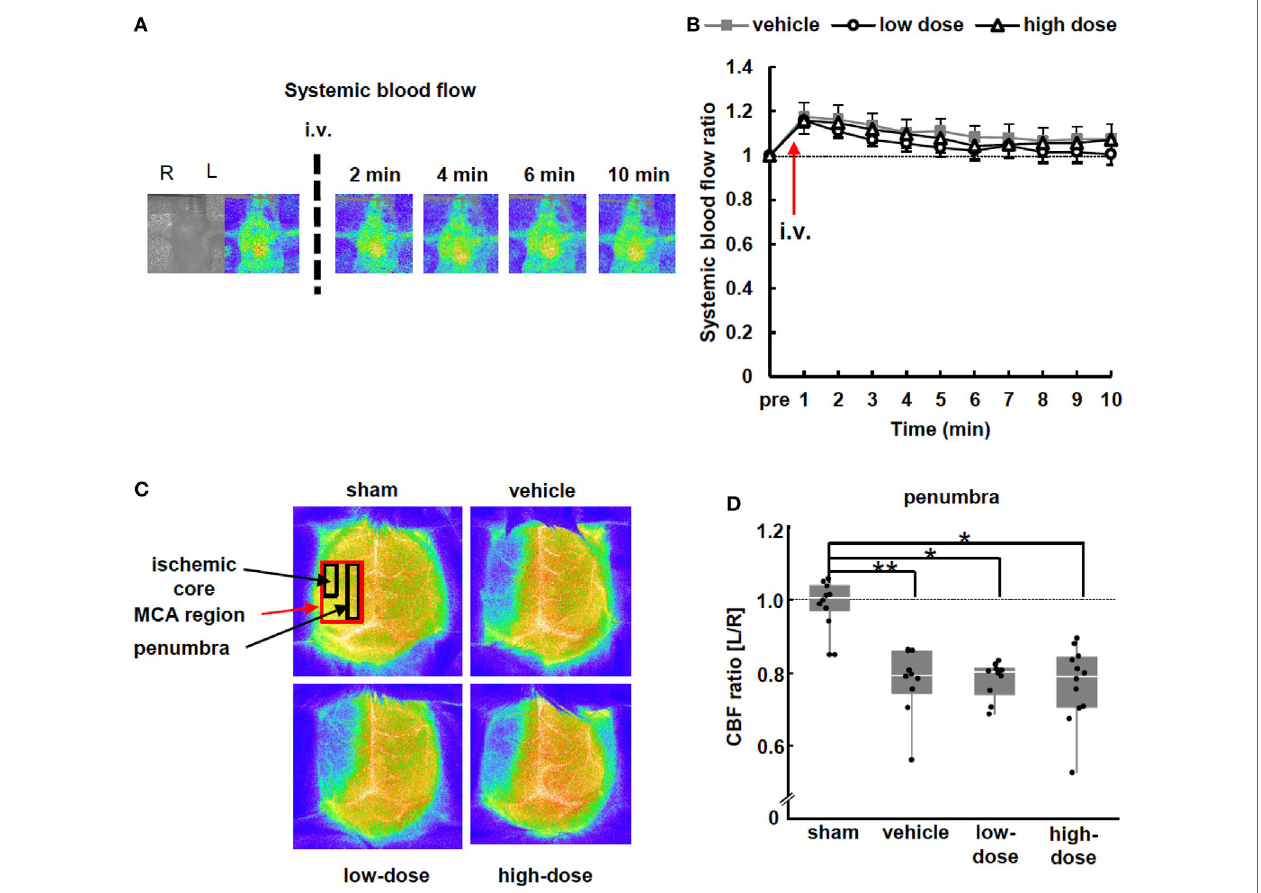
FigUre 2 | Blood flow measurements. (a) Representative images of systemic blood flow before and immediately after umbilical cord-derived MSC administration. (b) Systemic blood flow presented as a ratio to the pre-injection level. There were no significant differences between the vehicle and UC-MSC groups in systemic blood flow (vehicle n = 7, low-dose n = 8, and high-dose n = 8). (c) Representative images of cerebral blood flow (CBF) 24 h after administration. CBF decreased in the middle cerebral artery (MCA) region on the ipsilateral side of middle cerebral artery occlusion. (D) The CBF ratio of ipsilateral/contralateral hemispheres in the penumbra significantly decreased after MCAO. UC-MSC injection did not increase the CBF ratio. ** p < 0.01 and * p < 0.05 (sham n = 10, vehicle n = 10, low-dose n = 10, and high-dose n =